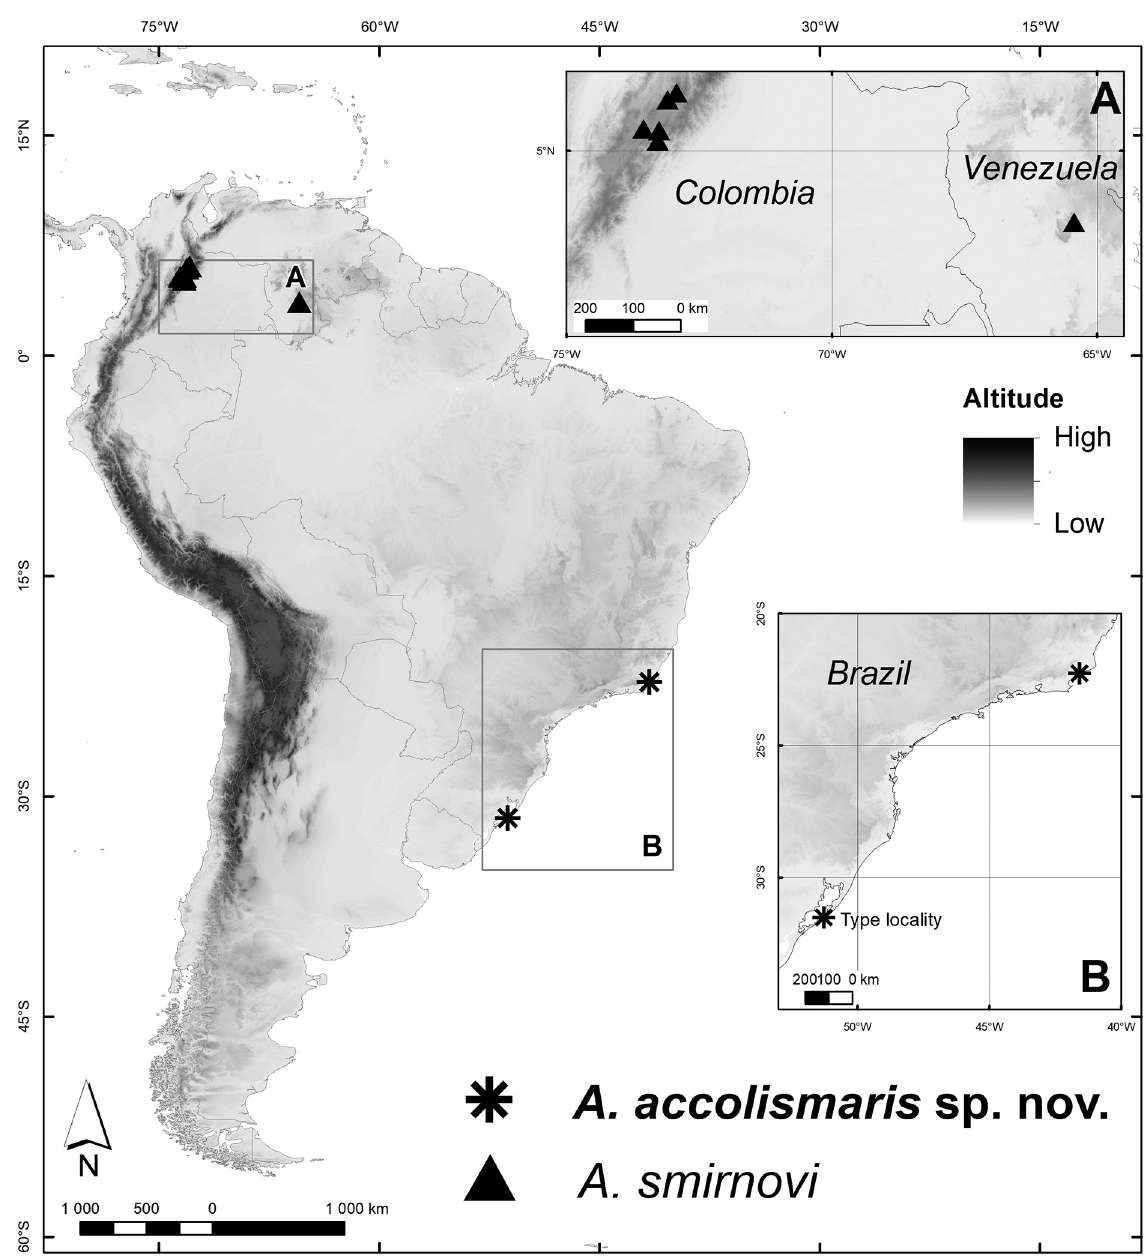
Fig. 1. Geographic distribution of species of Acantholeberis Lilljeborg, 1853 in South America. Black triangles represent previous records of A. smirnovi Paggi & Herrera-Martinez, 2020 (Paggi & Herrera- Martinez 2020) . Asterisks show records of A. accolismaris Sousa, Elmoor-Loureiro & Álvarez-Silva sp.